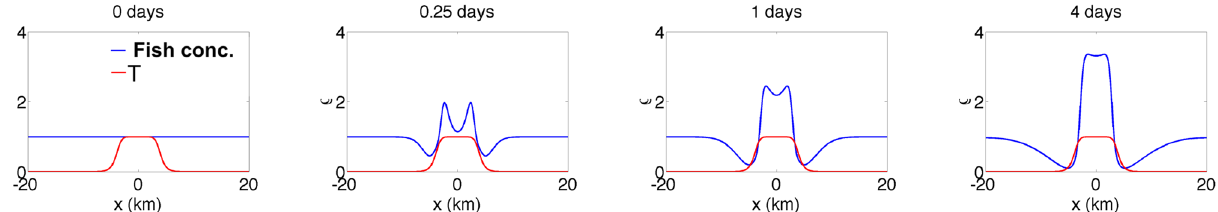
Figure 5. Time evolution of the fish concentration (blue line, adimensional) according to the continuity equation. The tracer (red line, adimensional) describes a plateau of 8 km in width. At its limits, its values range from 1 to 0 in about 5 km. Each panel represents a different snapshot at 0, 6 hours, 1 day, and 4 days.